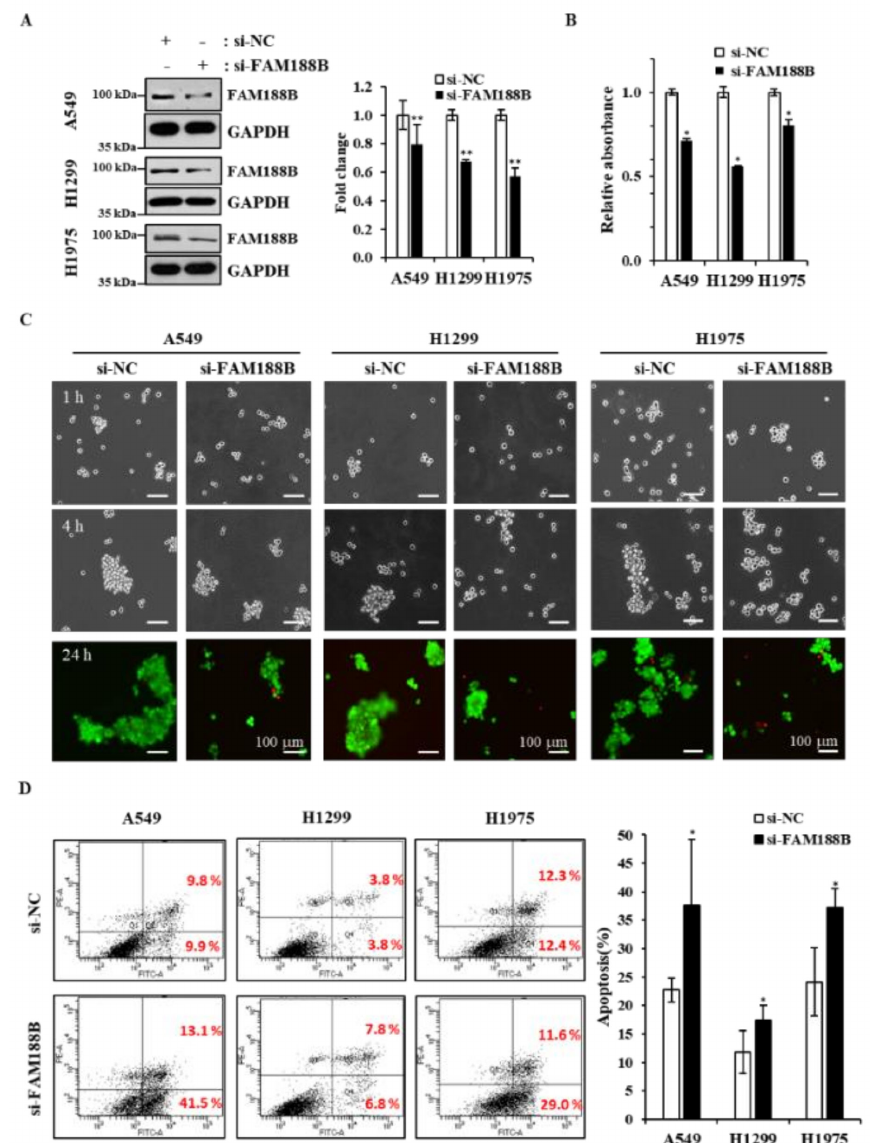
Figure 2. Effects of FAM188B knockdown on cell aggregation and apoptosis upon cell detach- ment. ( A – D ) Cells were transiently transfected with either si-NC or si-FAM188B for 48 h, and then cells were grown in the HEMA-coated plate for suspension culture for 24 h. Cells were then pro- cessed for immunoblot analysis using indicated antibodies ( A ), cell growth analysis by MTS ( B ), calcein- acetoxymethyl (AM)/PI staining for live/dead cell assay at indicated times ( C ), or annexin V/PI staining for apoptosis assay ( D ) as described in the “Materials and Methods”. The levels FAM188B were quantified by densitometry and normalized to GAPDH ( A , right panel). Data are presented as mean values from three measurements, and error bars represent standard deviations. (* p < 0.05, ** p < 0.01 versus si-NC). Scale bars = 100 µ m. These experiments were performed three times independently with similar